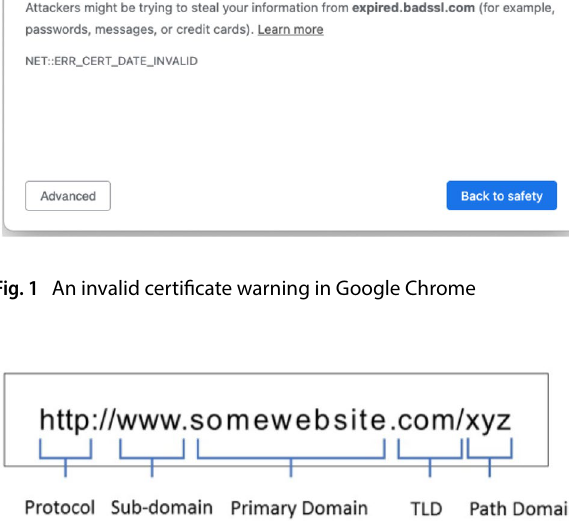
Fig. 2 Structure of a typical URL